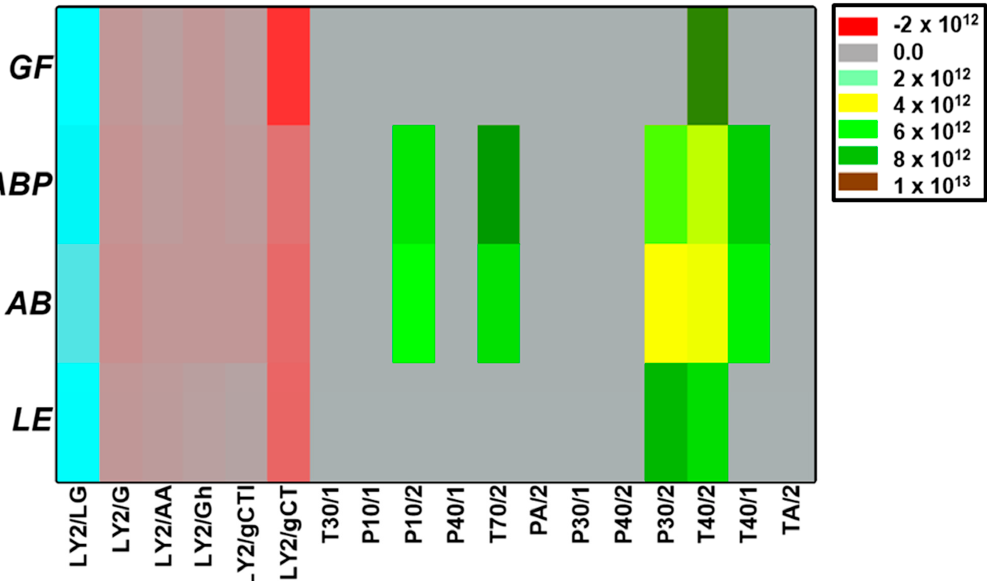
Figure 1. Response intensity of the 18 sensors from the electronic nose for the different freeze-dried samples from cultivated mushrooms (AB: Agaricus bisporus sp. bisporus ; ABP: Agaricus bisporus sp. brunnescens ; LE: Lentinula edodes ; GF: Grifola frondosa ).